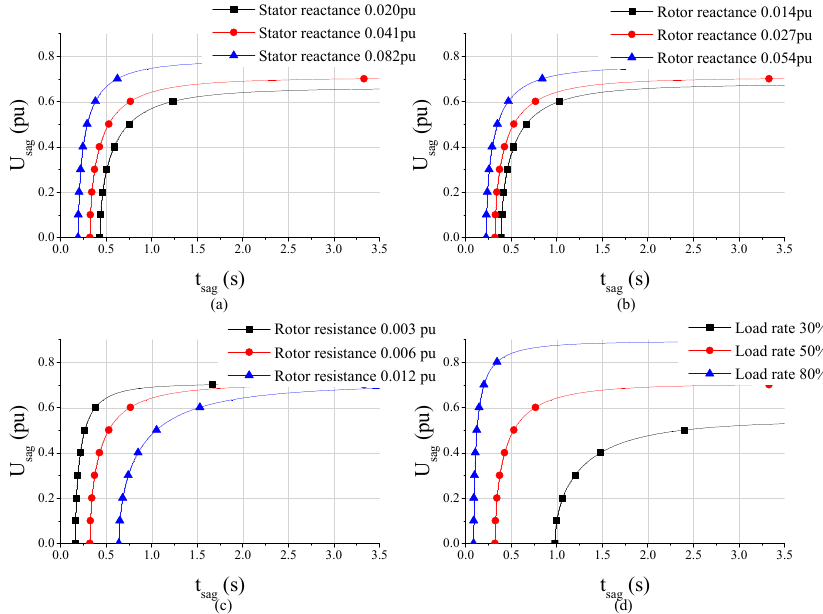
Figure 5. Transient voltage stability boundaries: ( a ) transient voltage stability boundaries for dif- ferent values of stator reactance; ( b ) transient voltage stability boundaries for different values of rotor reactance; ( c ) transient voltage stability boundaries for different values of rotor resistance; ( d ) Transient voltage stability boundaries for different load rates.